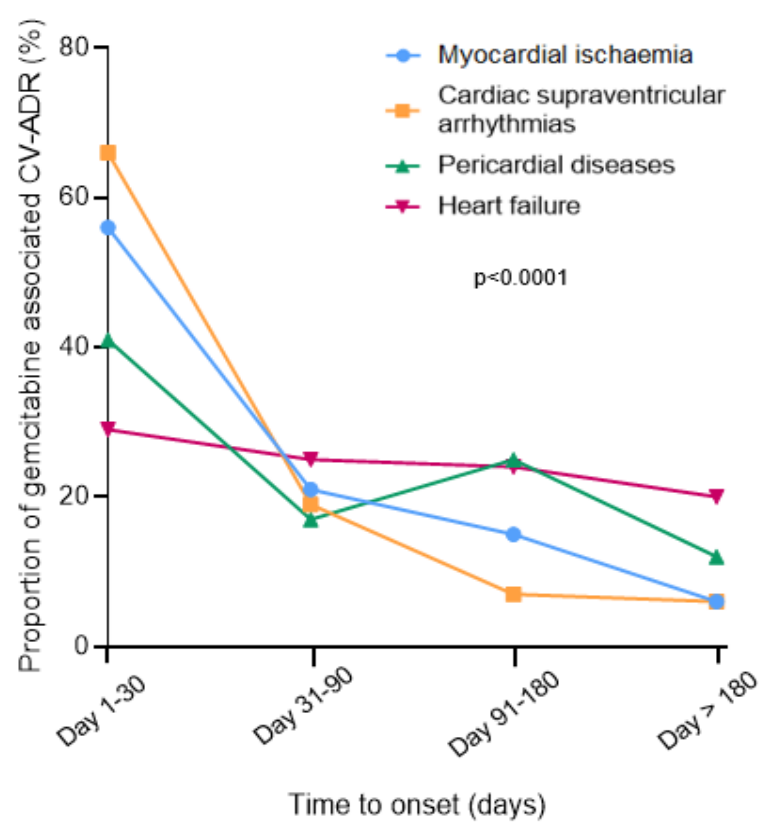
Figure 2. Time to event onset for gemcitabine-associated cardiovascular adverse drug reactions (CV-